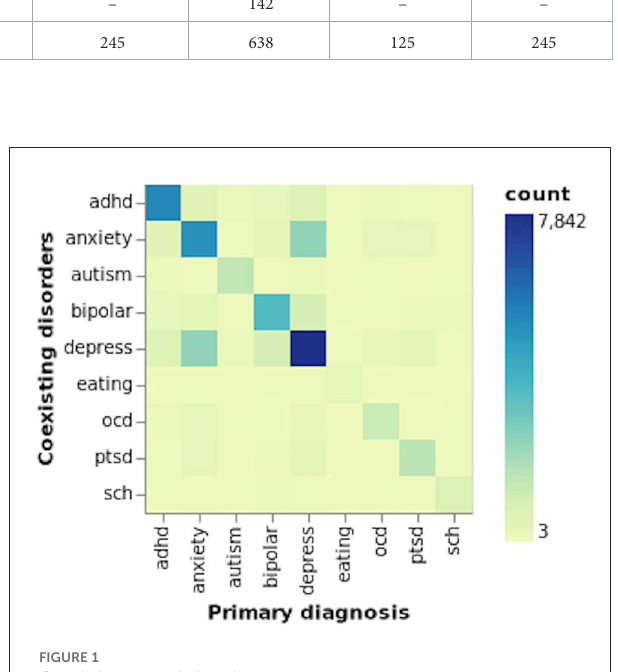
FIGURE1 Coexisting mental